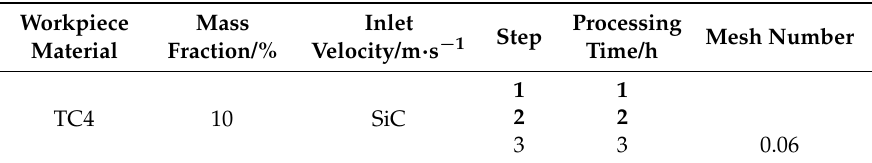
Table 2. Processing experiment